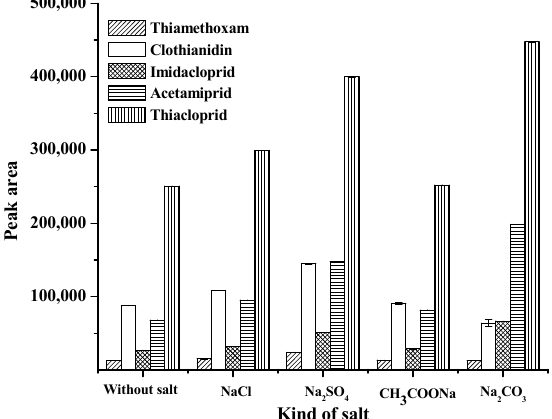
Figure 1. E ff ect of salt addition on the extraction of studied Figure 1. Effect of salt addition on the extraction of studied neonicotinoids.